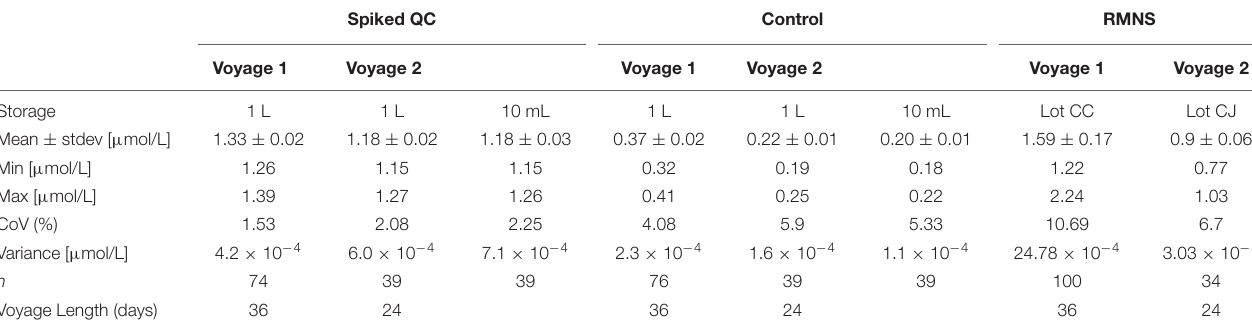
TABLE 1 | Ammonium mean concentration and standard deviation (Stdev) in µ mol/L, minimum and maximum concentration (in µ mol/L), coefficient of variation (CoV, in%), variance (in µ mol/L) and number of samples analyzed from bulk solution, 10 mL tubes, and reference material for nutrients in seawater (RMNS) (n) during voyage 1 and voyage 2, and length of the voyage (in